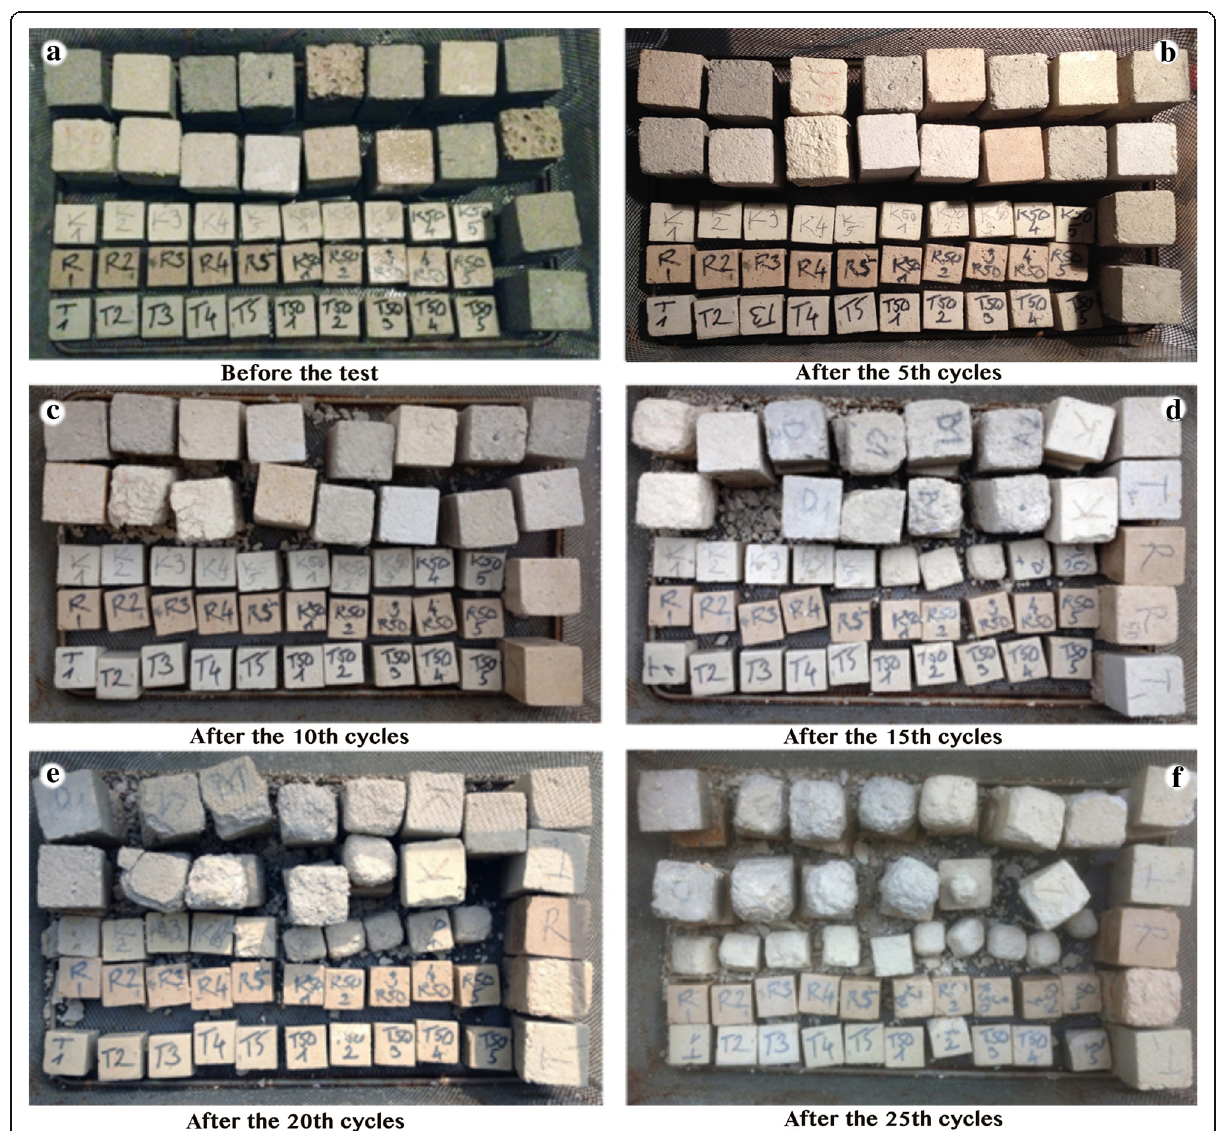
Fig. 4 Samples before the frost test ( a ), after the 5th freeze-thaw cycles ( b ), after the 10th freeze-thaw cycles ( c ), after the 15th freeze-thaw cycles ( d ), after the 20th freeze-thaw cycles ( e ), and after the 25th freeze-thaw cycles ( f